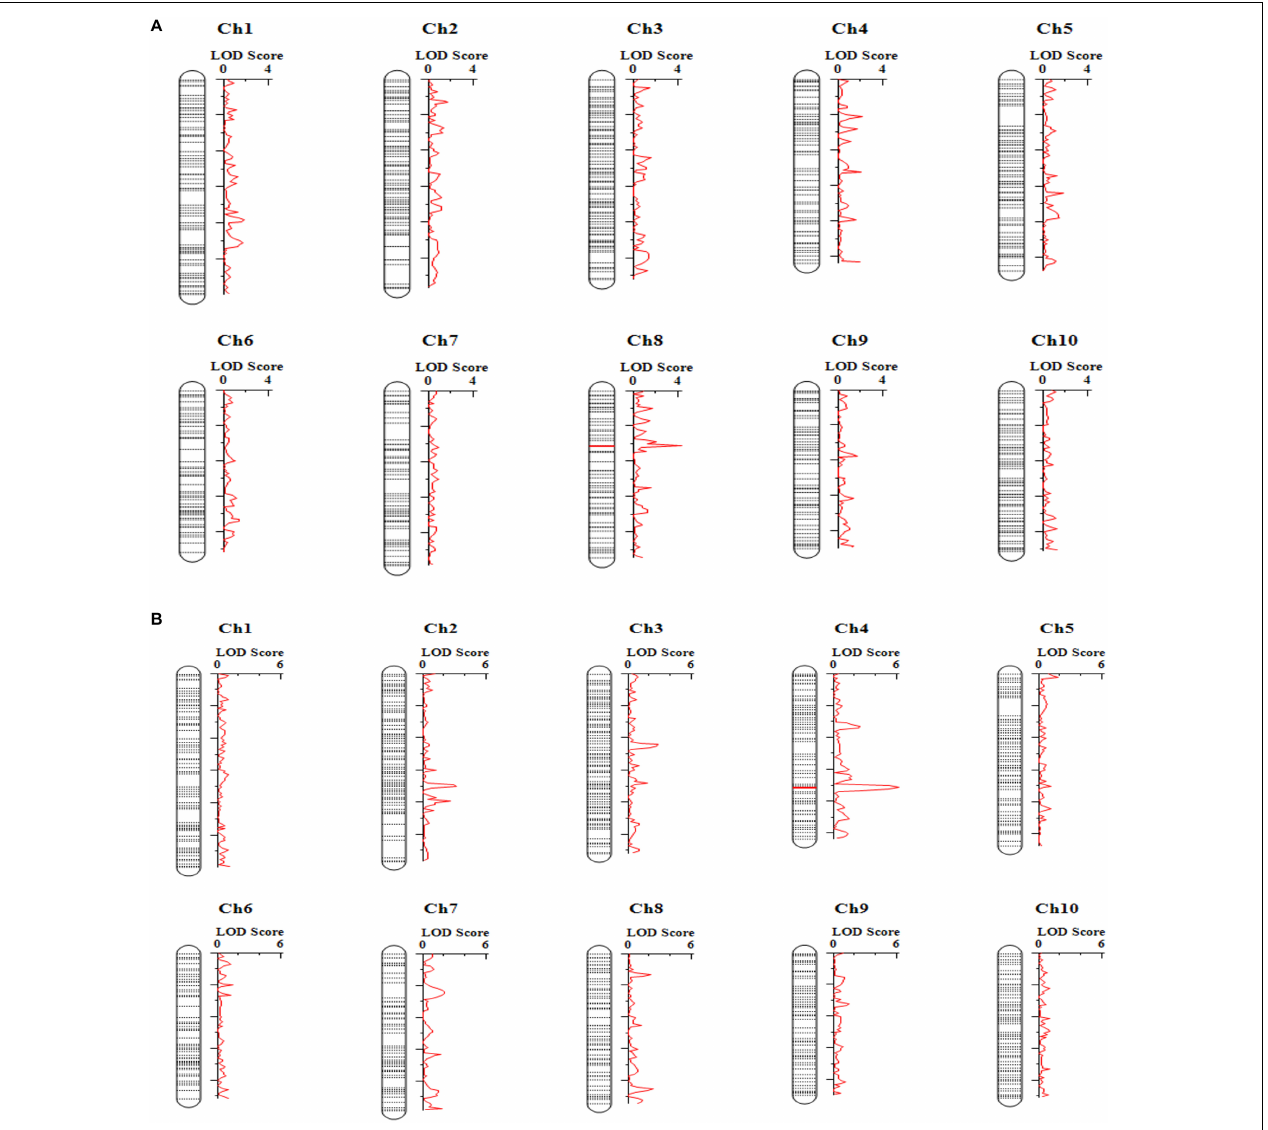
FIGURE 7 | Quantitative trait loci (QTLs) detected from analysis of 150 plants from a single F 2 family of S-1 × G-200 for different traits: (A) recovery (RE); (B) visual injury 21 days after treatment (VI).